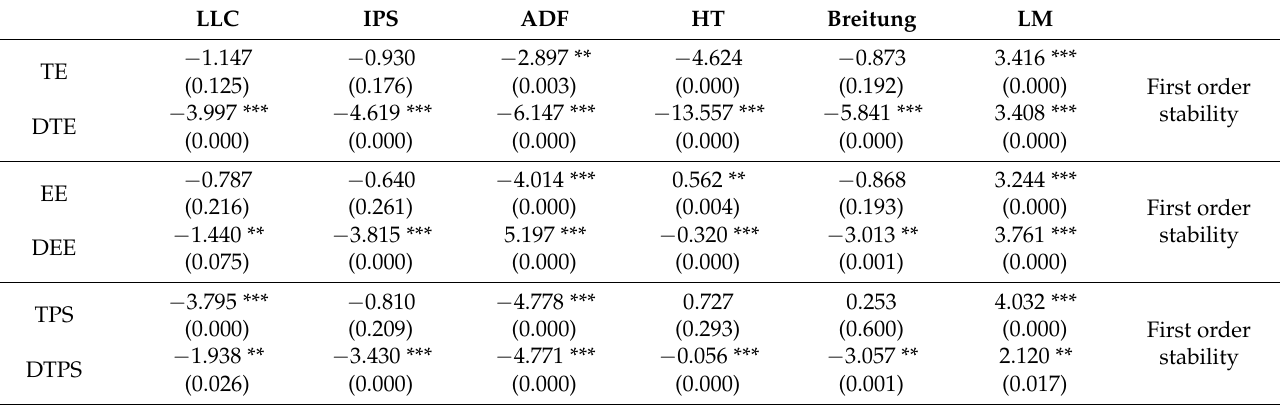
Table 7. Unit Root Test Results.